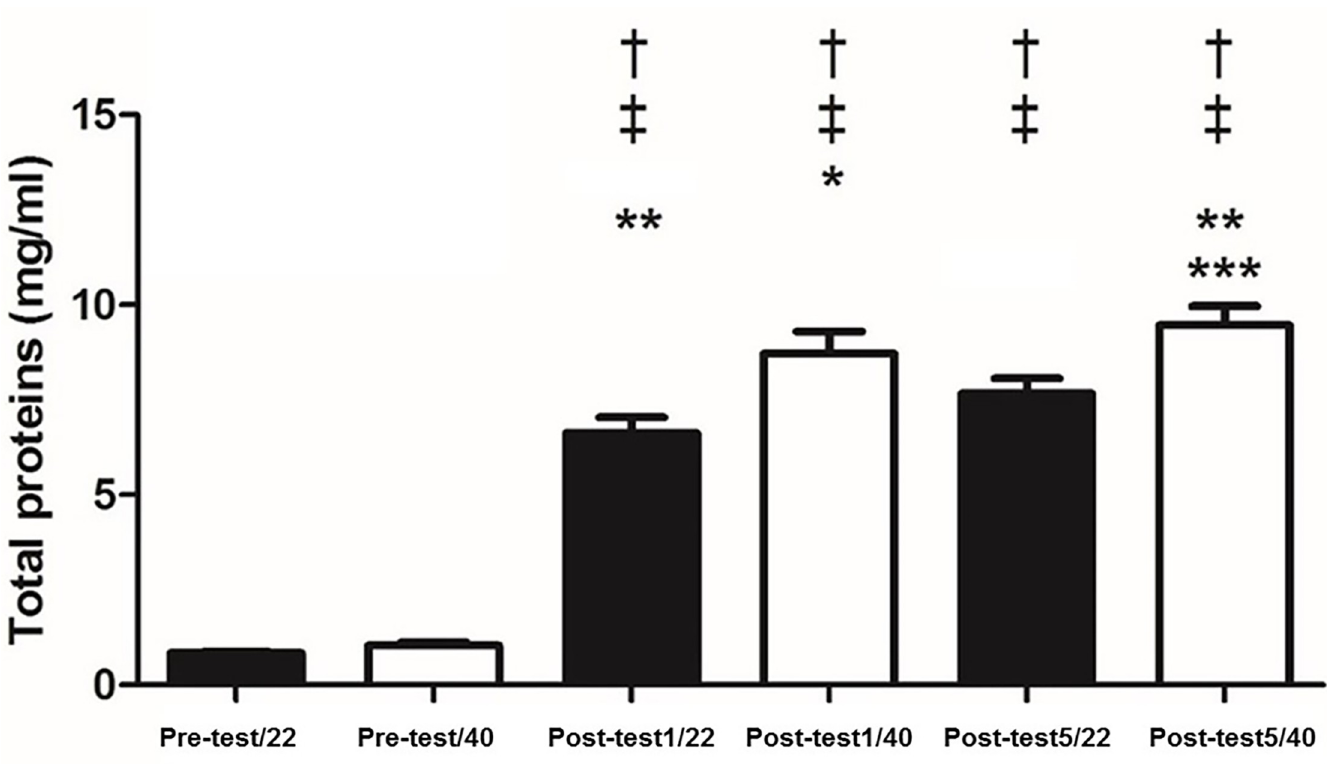
Fig 4. Concentrations of total salivary proteins pre-test and at one (Post-test1) and five minutes (Post-test5) after exhaustion at 22 and 40˚ C. † p < 0.05 different from Pre-test1/22; ‡ p < 0.05 different from Pre-test1/40; � p < 0.05 different from Post-test1/22; �� p < 0.05 different from Post-test1/40; ��� p < 0.05 different from